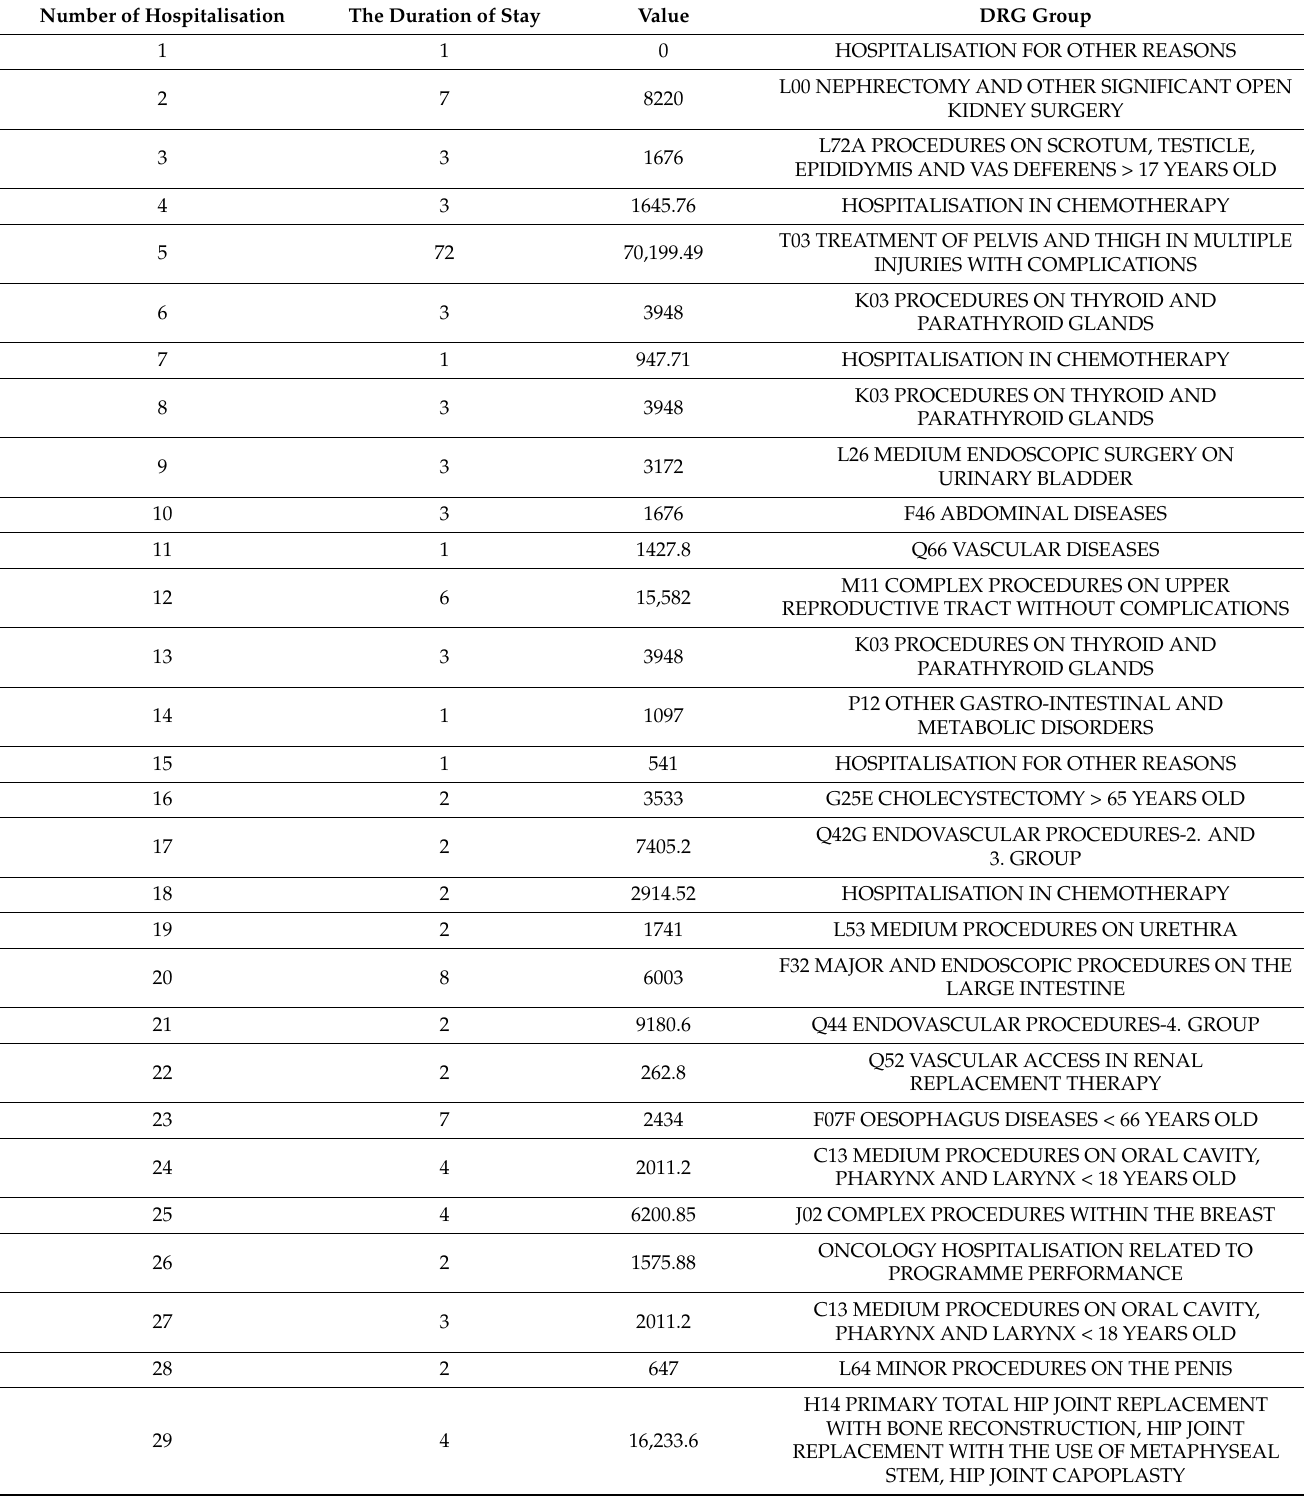
Table 2. Example/fragment list of hospitalisations, taking into account the duration of stay, DRG settlement group and its value